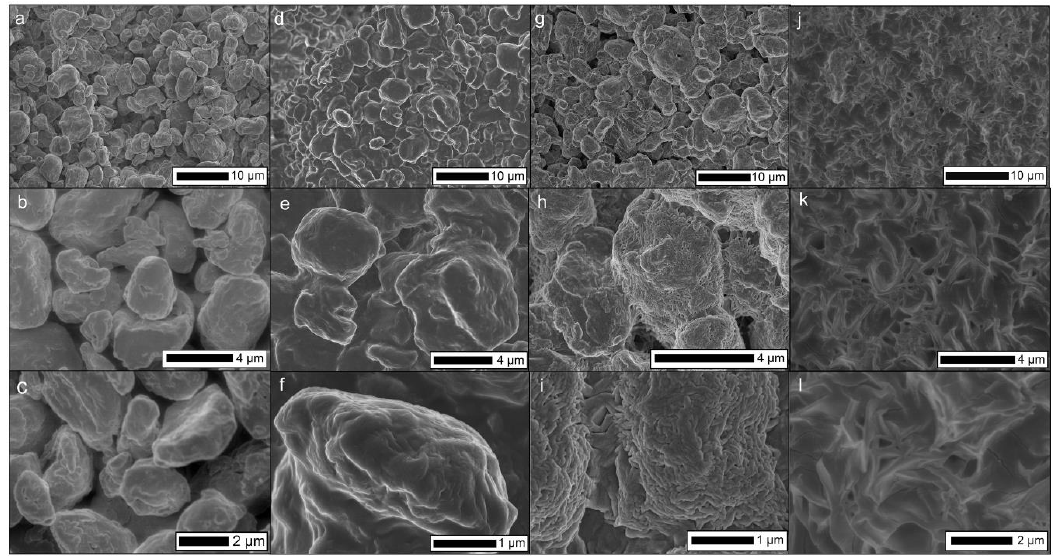
Figure 4. SEM images of S-µ PE powder under different heat treatments, where ( a – c ) shows a loose powder without heat treatment, and with heat treatment at 114 °C ( d – f ), 140 °C ( g – i ), and 160 °C ( j – l